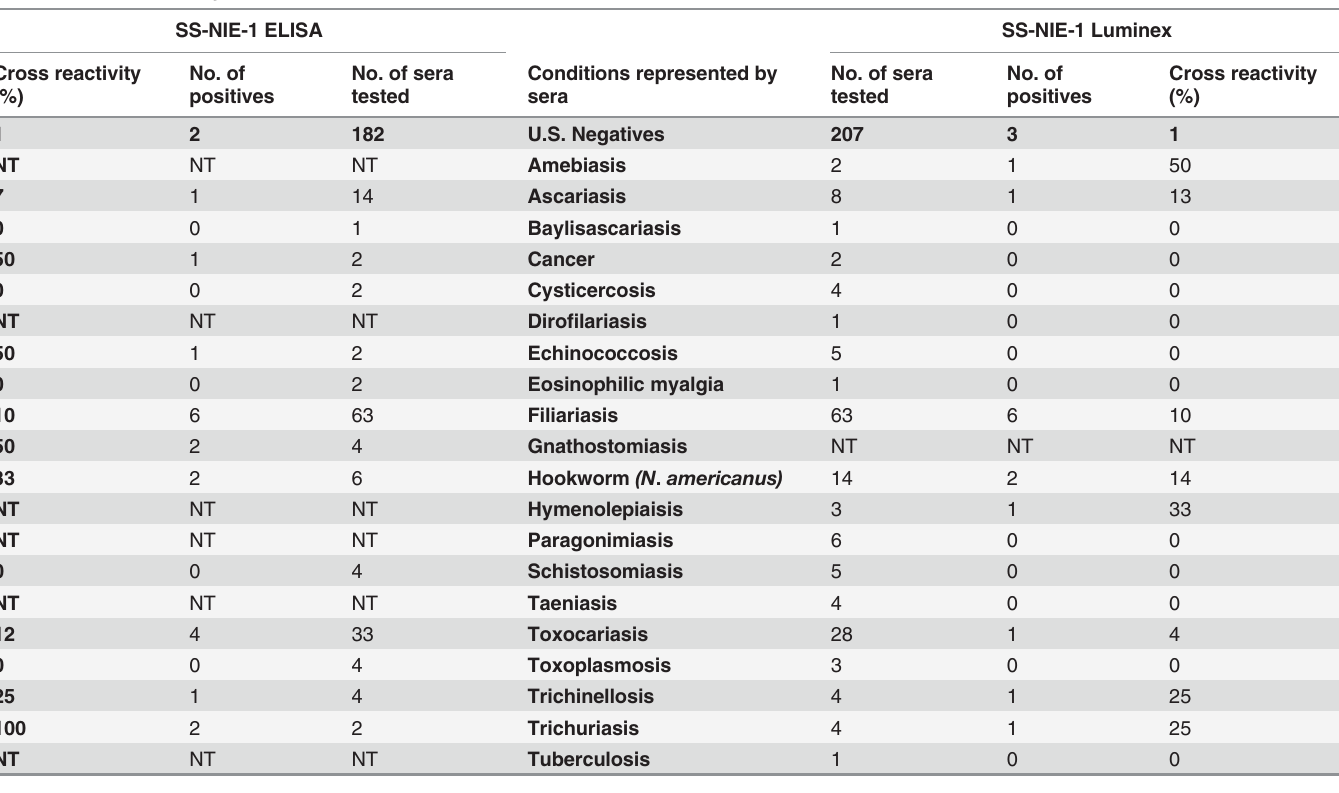
Table 2. Cross-reactivity of SS-NIE-1 ELISA and Luminex. SS-NIE-1